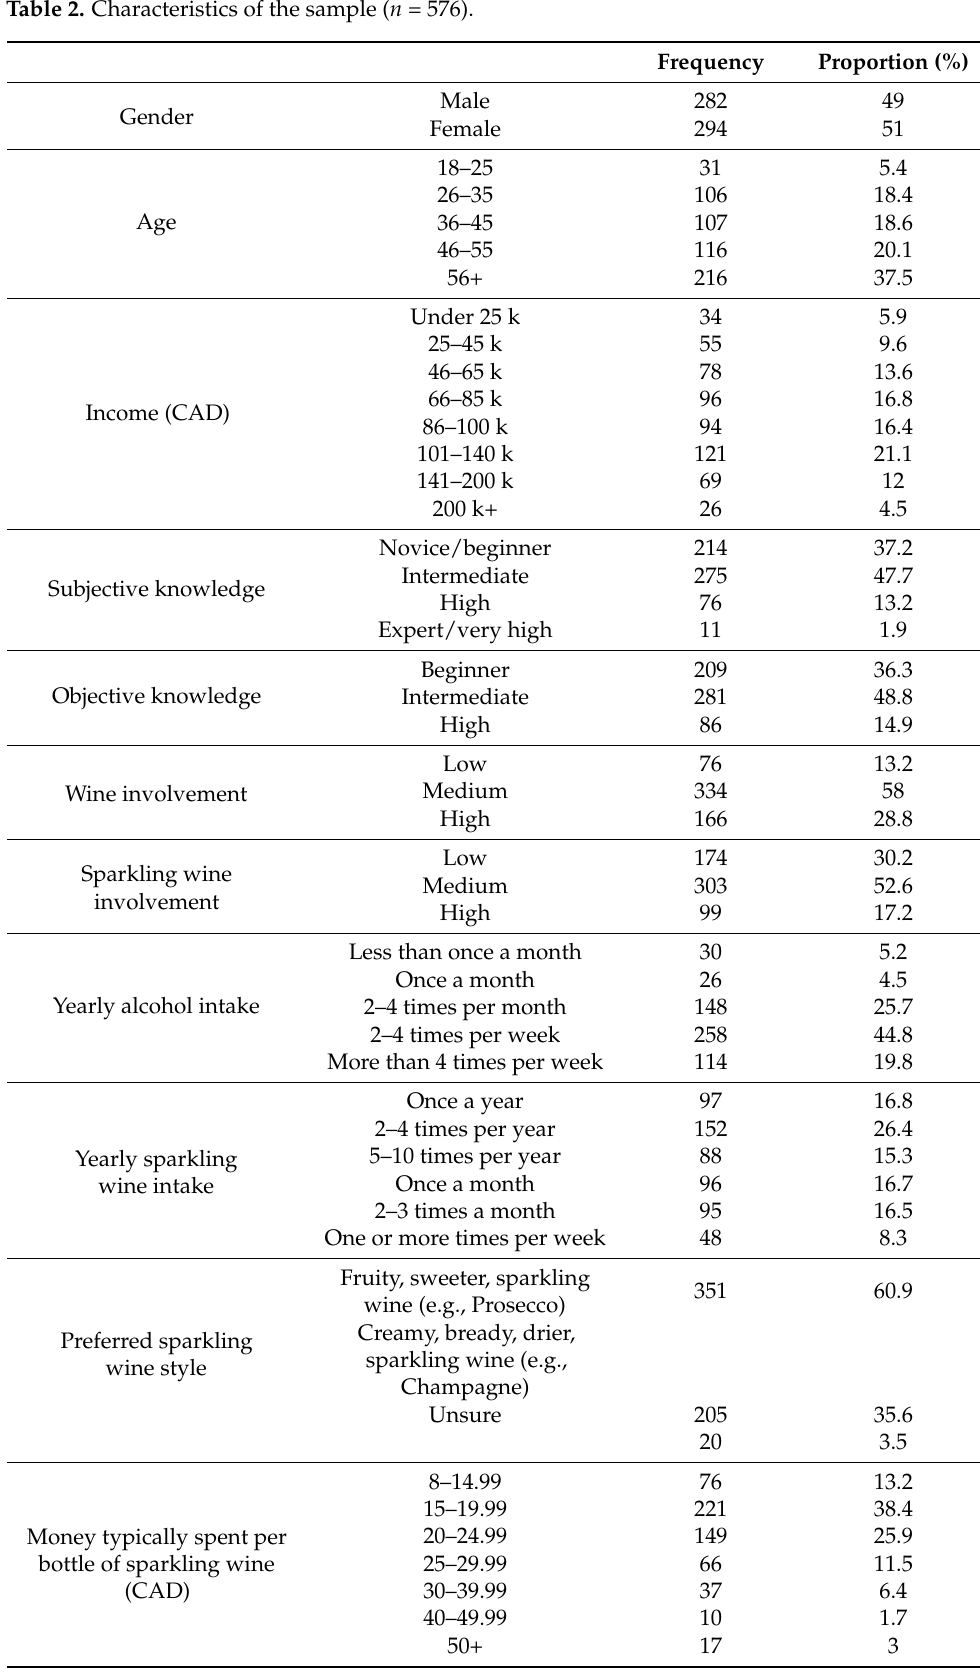
Table 2. Characteristics of the sample ( n =